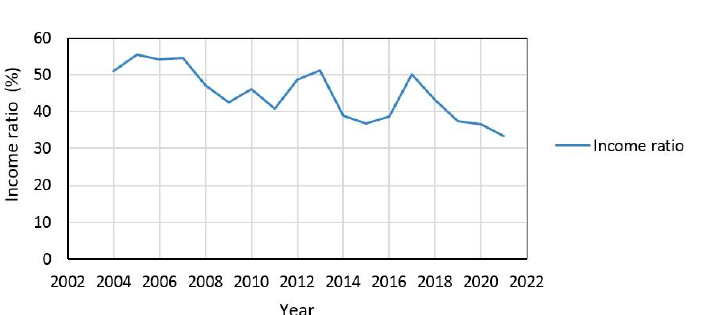
Figure 21. Rural and urban communities economics in 2004–2021, data obtained from [66]: ( a ) communities incomes per 1 resident, ( b ) communities expenditures per 1 resident.